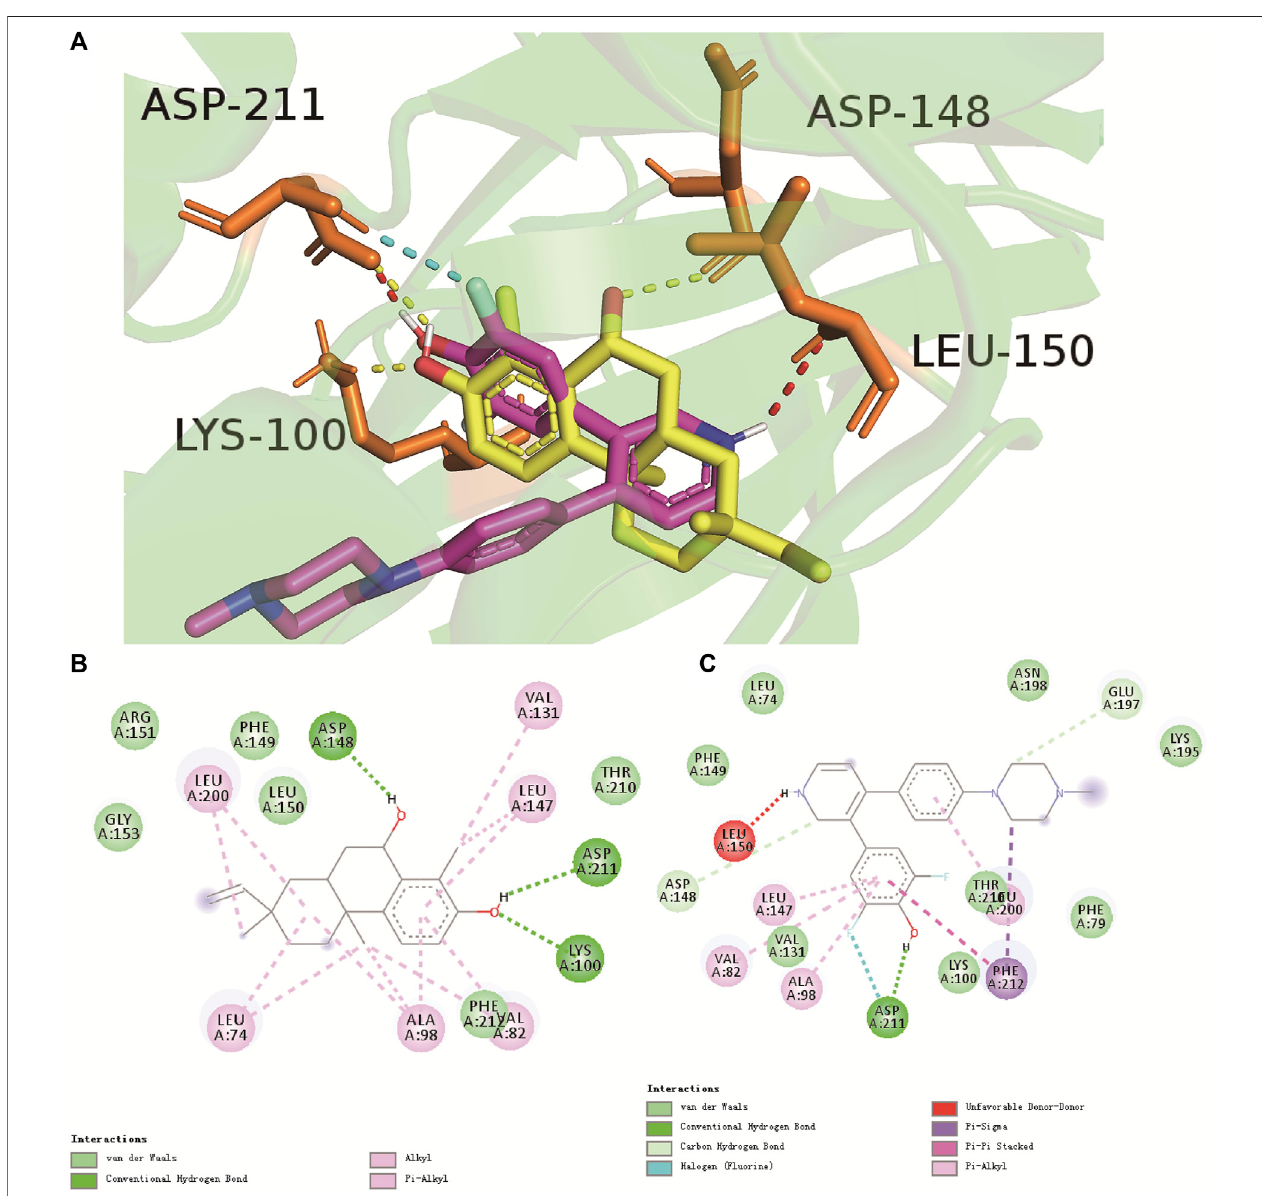
FIGURE 4 | Binding mode of compound 1 (yellow) and LJH685 (purple) against RSK (PDB ID: 4NUS). (A) Three-dimensional overlaid pose diagrams. The yellow dotted line signi fi es the hydrogen bond of compound 1 , red and blue dotted lines represent the hydrogen bond of LJH685. (B) Two-dimensional binding modes of compound 1 and RSK. (C) Two-dimensional binding modes of LJH685 and RSK. Green lines represent the hydrogen-bonding interaction, aqua blue signi fi es van der Waals forces, and lilac represents alkyl and Pi-alkyl groups.